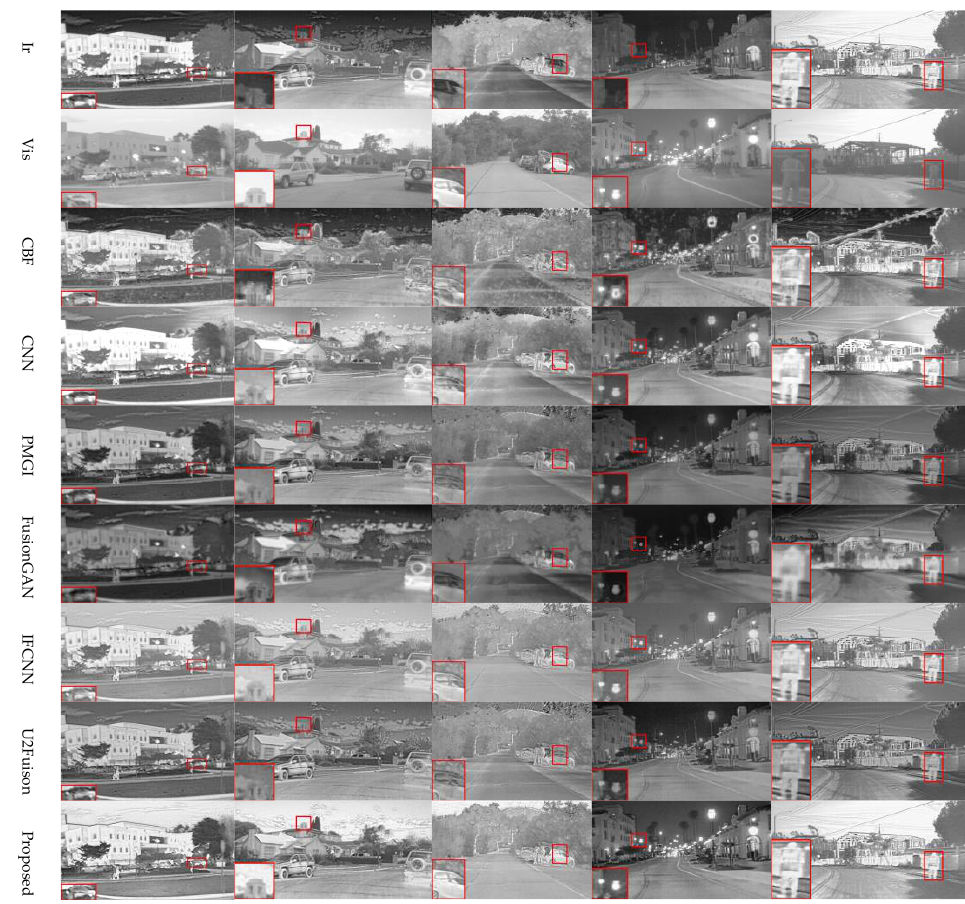
Figure 13. Experimental results of different fusion methods.